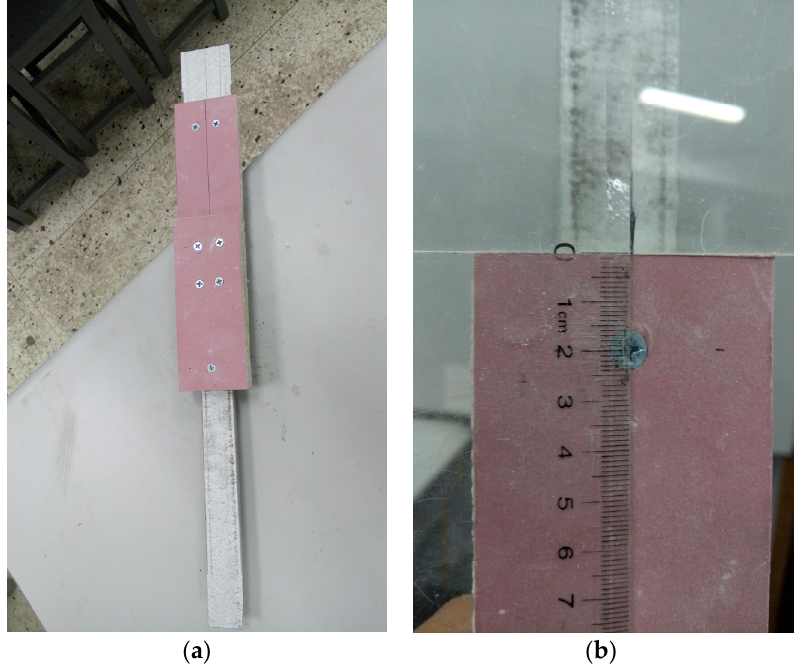
Figure 4. A typical screw connection specimen: ( a ) side view; and ( b ) verification of the loaded edge distance (20 mm).